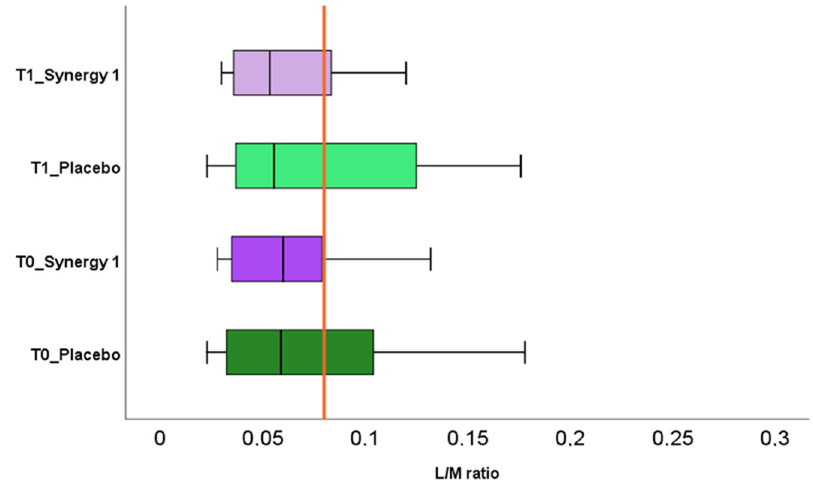
Figure 1. Urinary lactulose (L) to mannitol (M) ratio in Synergy 1 and placebo group, before (T0) and after the intervention (T1). The red line indicates the reference value (0.08).